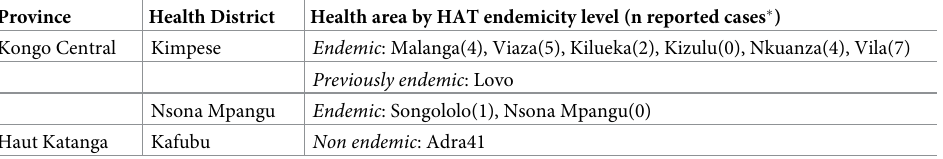
Table 1. Overview of the study sites and HAT endemicity